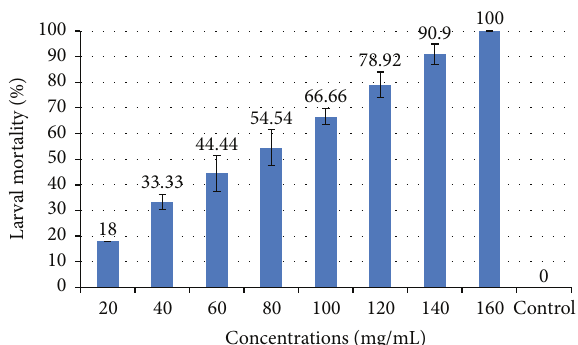
Figure 1: Percentage of mortality recorded in the test sensitivity by aqueous extract of a plant on C. pipiens .